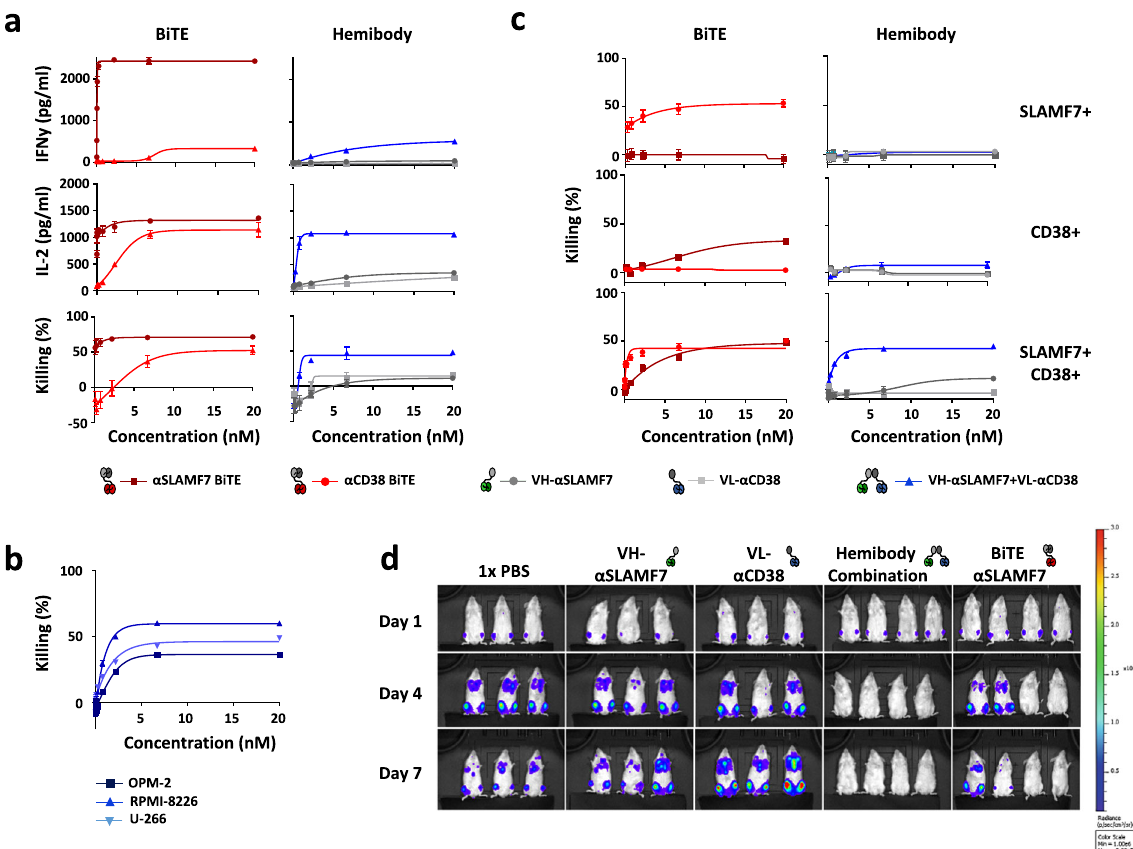
Fig. 3 Ultra-precise immunotherapy by hemibodies in vitro and in vivo. a Luciferase-positive MM.1S cells were co-cultivated with PBMCs (ratio effector: target cell = 5:1) and constructs as indicated for 24h. Antibody-initiated T cell activation was measured by IL-2 and IFN- γ secretion (top two panels) using ELISA and tumor cell lysis by luciferase-based cytotoxicity assay (bottom panel) (IL-2 and IFN- γ n = 3, cytotoxicity n >3, pooled data are shown). b